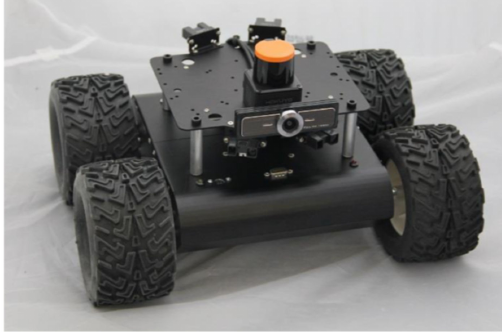
Figure 4. WiFibot moving into the warehouse.